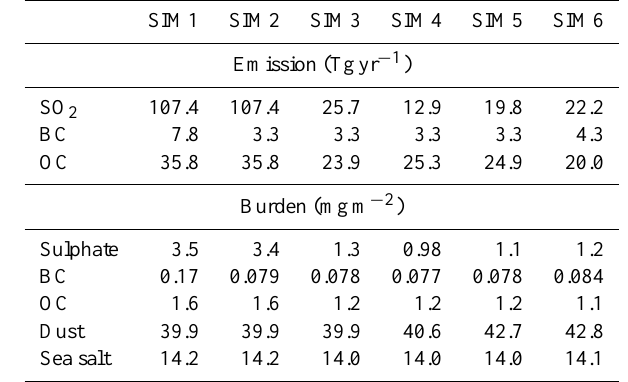
Table 2. Global amounts of aerosol emissions and annual means of aerosol burdens.